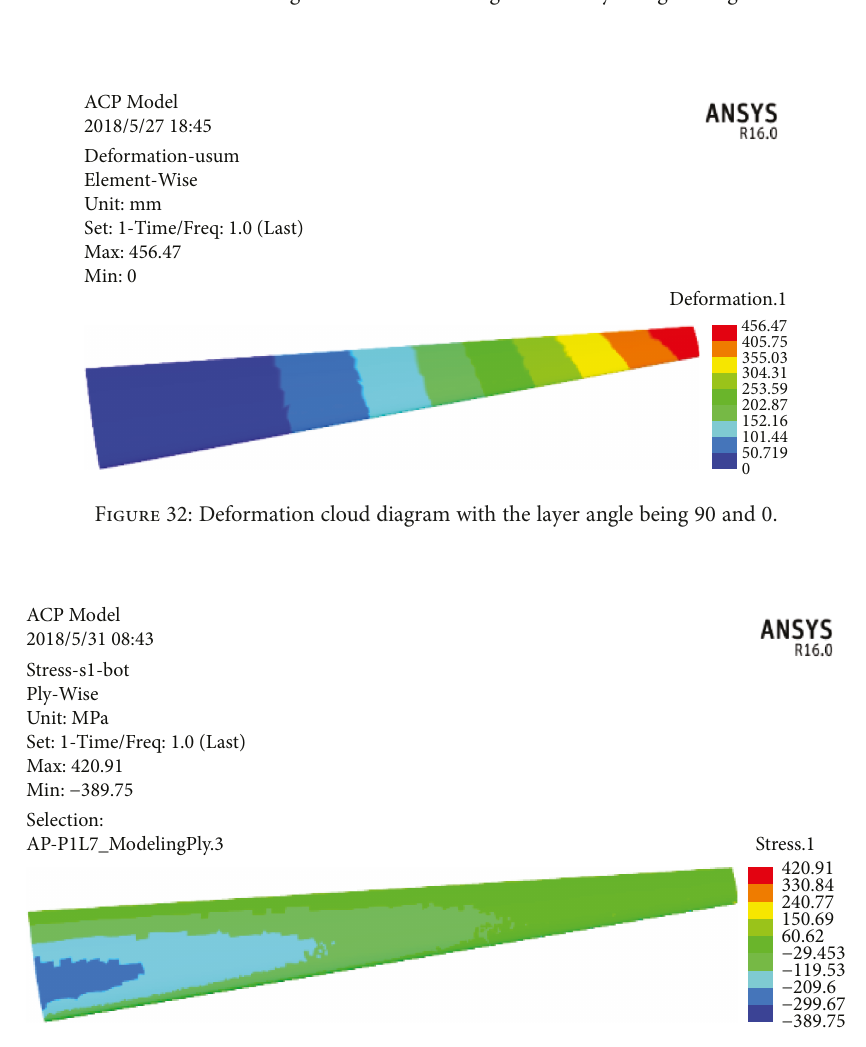
Figure 31: Stress cloud diagram of the lower wing with the layer angle being 45 and 0.